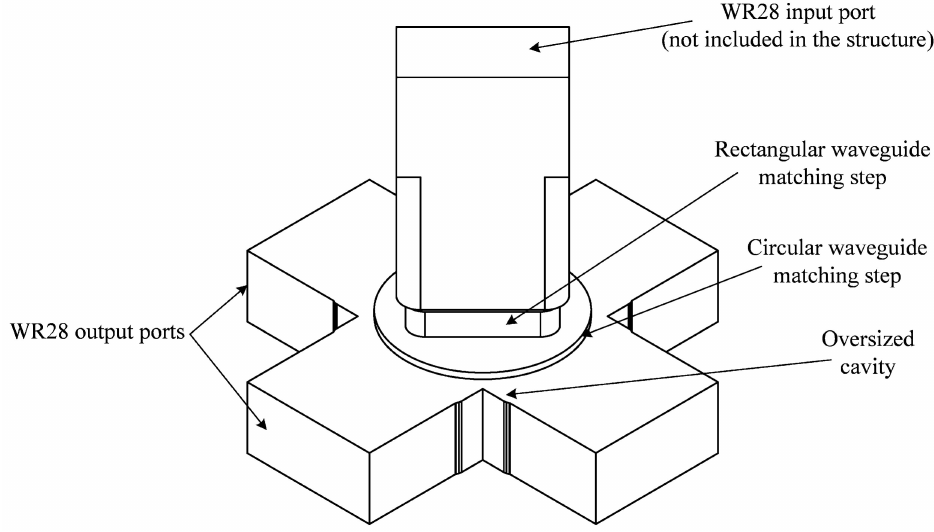
Figure 1. 3D sketch of the turnstile-based junction in the proposed power